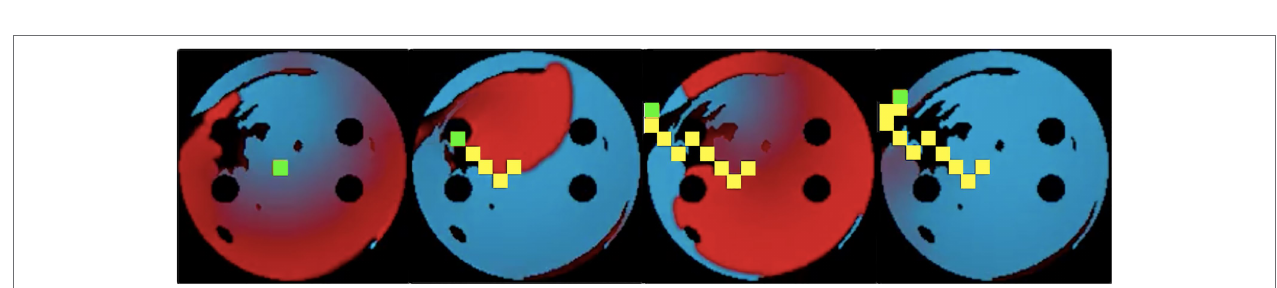
FIGURE 5 | Training sequence at 10 ms ablation interval with the ablator (green) successfully ablating the rotor by following its tip. Same colour code is used for the voltage maps as in Figure 2 . Ablated tissue is shown by 9 × 9 pixel yellow